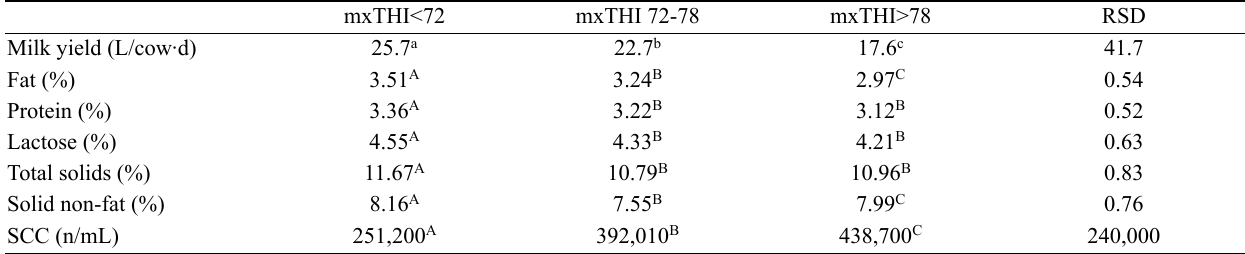
Table 3. Least square means of milk characteristics from lactating Frisian cows exposed to different temperature-humidity